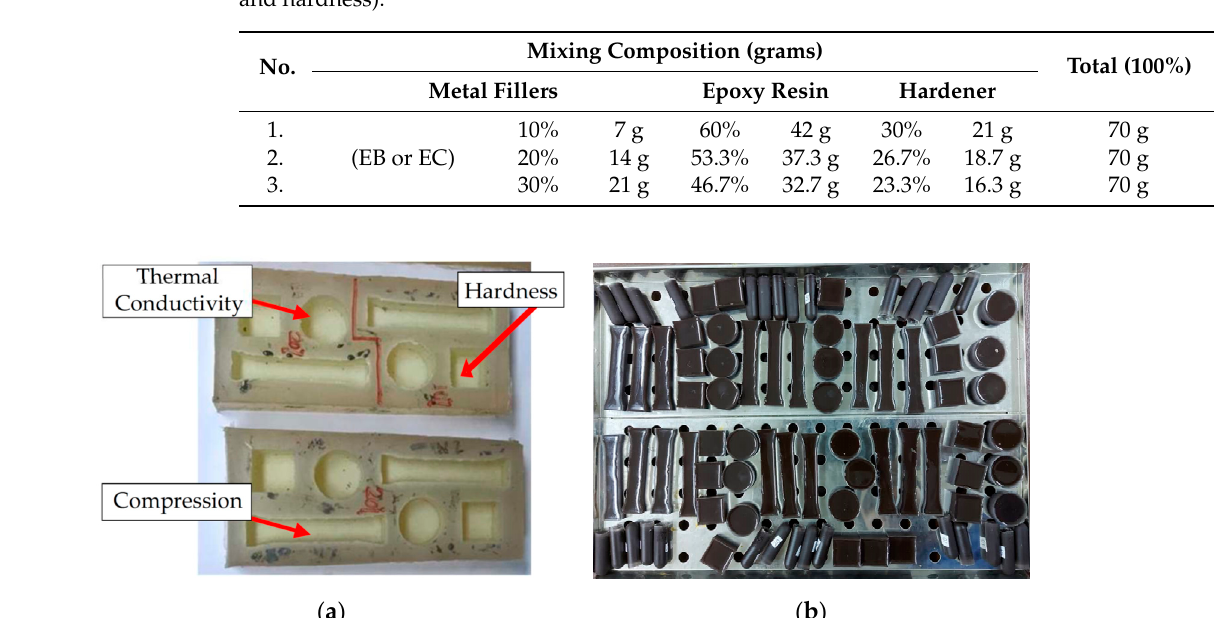
Figure 3. Specimen preparation: ( a ) silicone rubber mold; ( b ) MEC test samples.